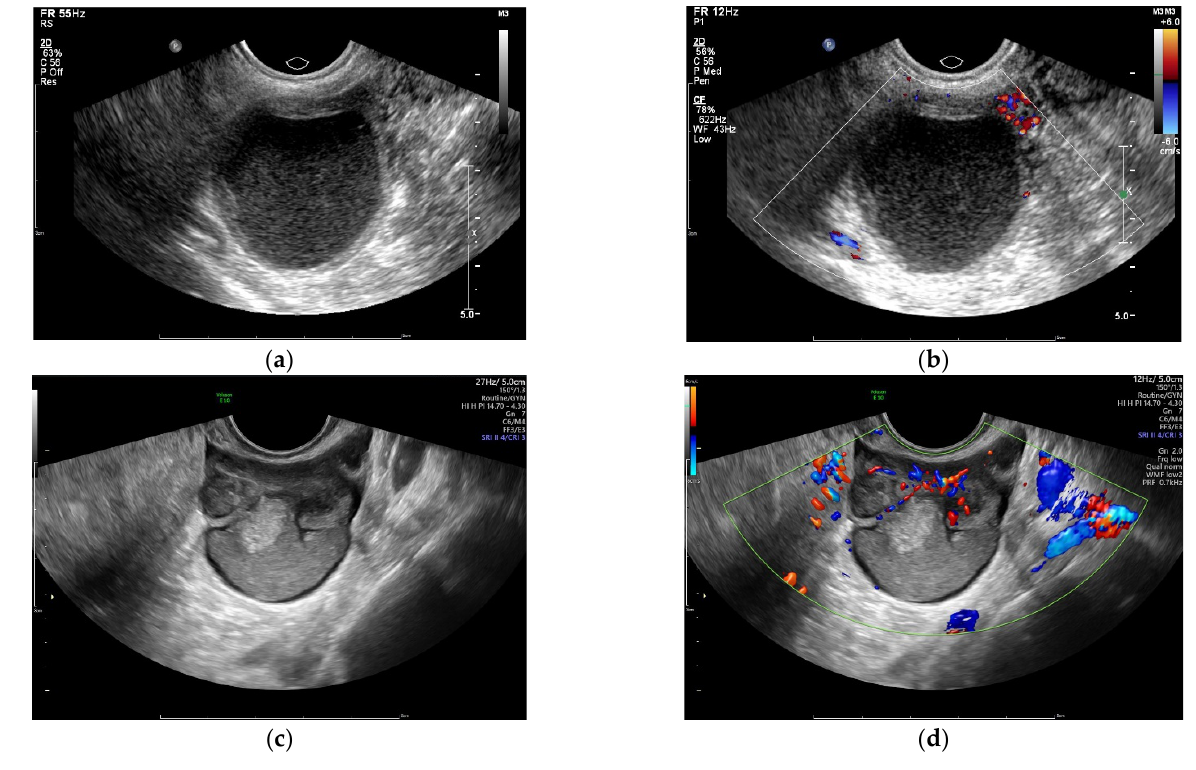
Figure 1. Sonographic images of endometriosis cysts confirmed by pathology: ( a , b ) unilocular cyst without color Doppler flow; ( c , d ) multilocular cyst/solid tumor with abundant color Doppler flow.